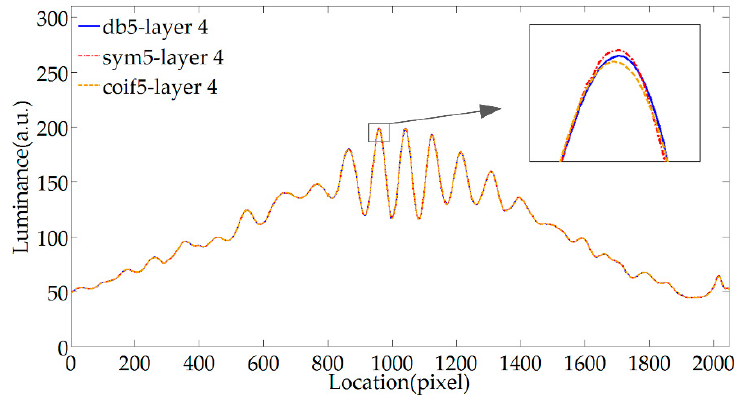
Figure 4. Filtering effects of different wavelet basis functions.